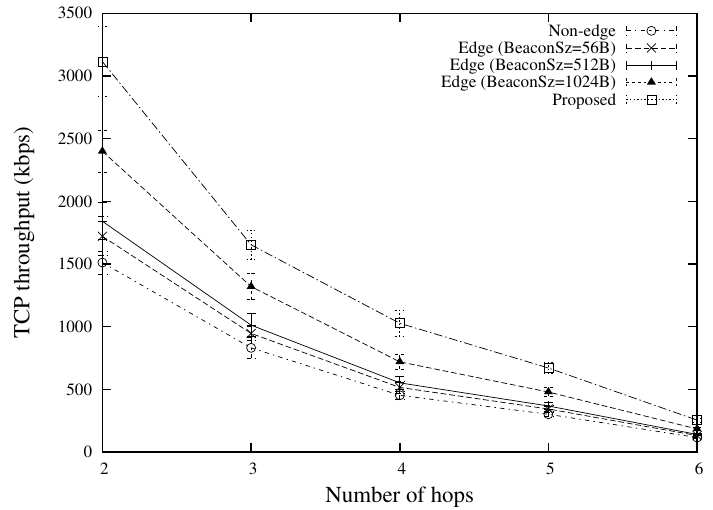
Figure 13. TCP throughput for various numbers of hops (the case of 10 TCP